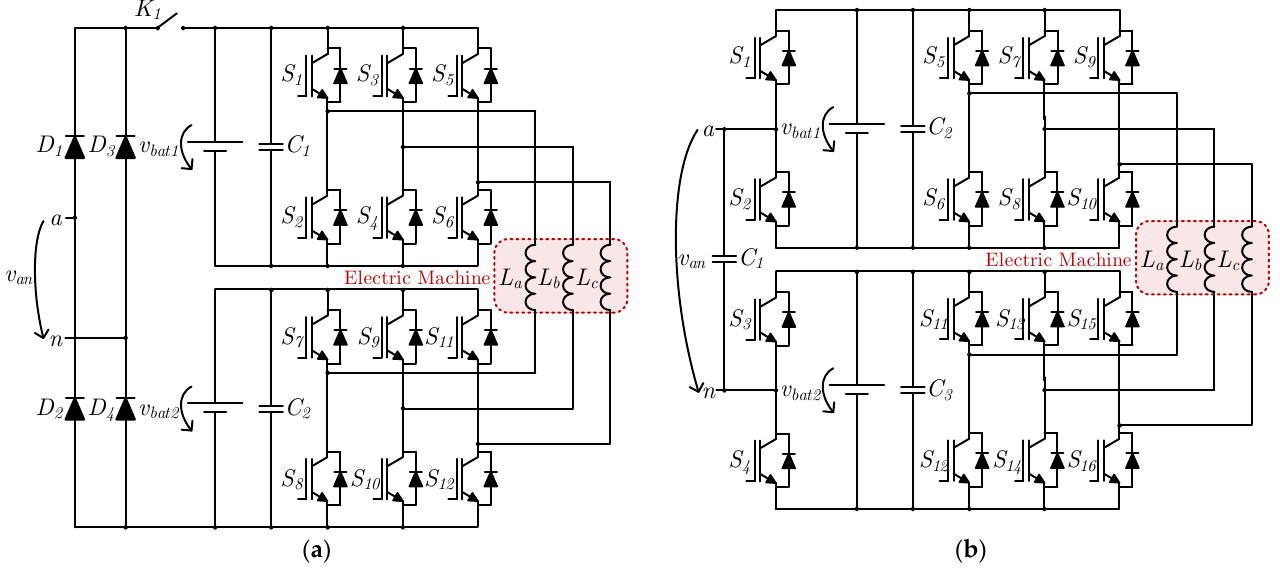
Figure 17. EV IBCs based on two traction converters proposed by S. Semsar et al. in: ( a ) 2018 [35]; ( b ) 2020 [36].